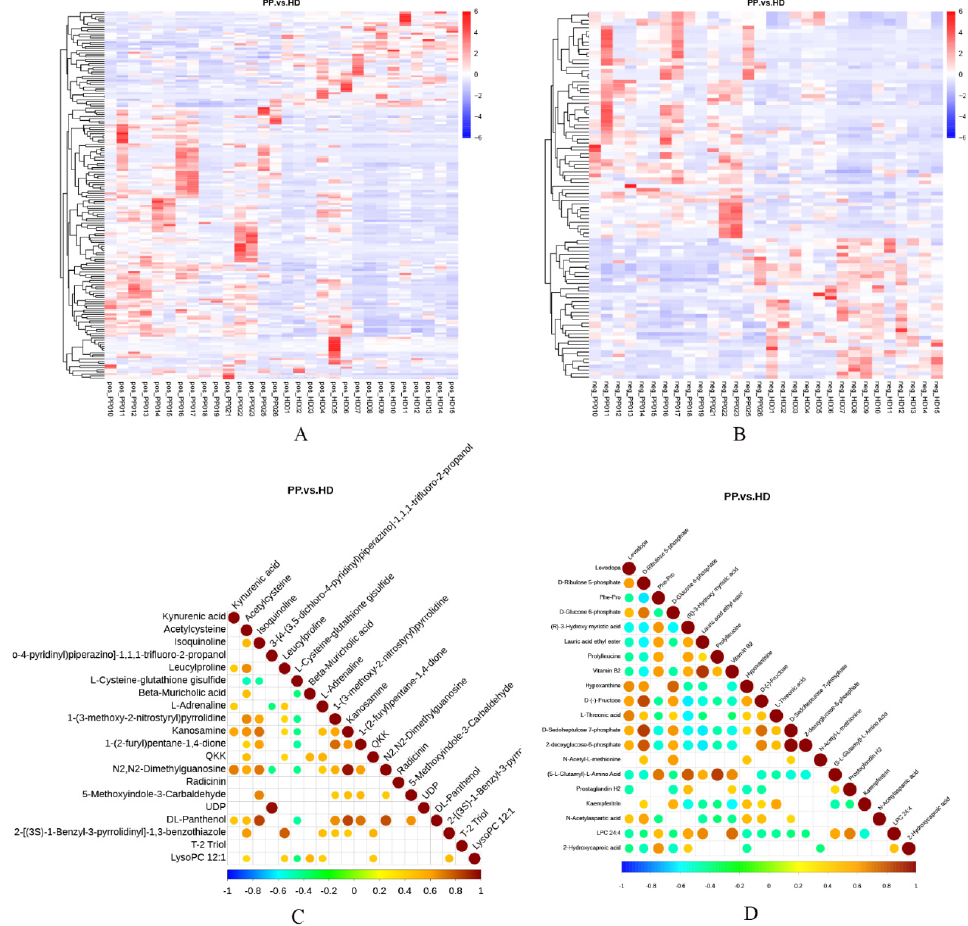
Figure 4. Correlation analysis of differential metabolites of endometrial tissues between dogs with pyometra and healthy dogs. ( A , B ). Heat map visualization of differential metabolites in the positive ( A ) and negative ( B ) modes; ( C , D ). Correlation diagram of differential metabolites in the positive ( C ) and negative ( D ) modes.